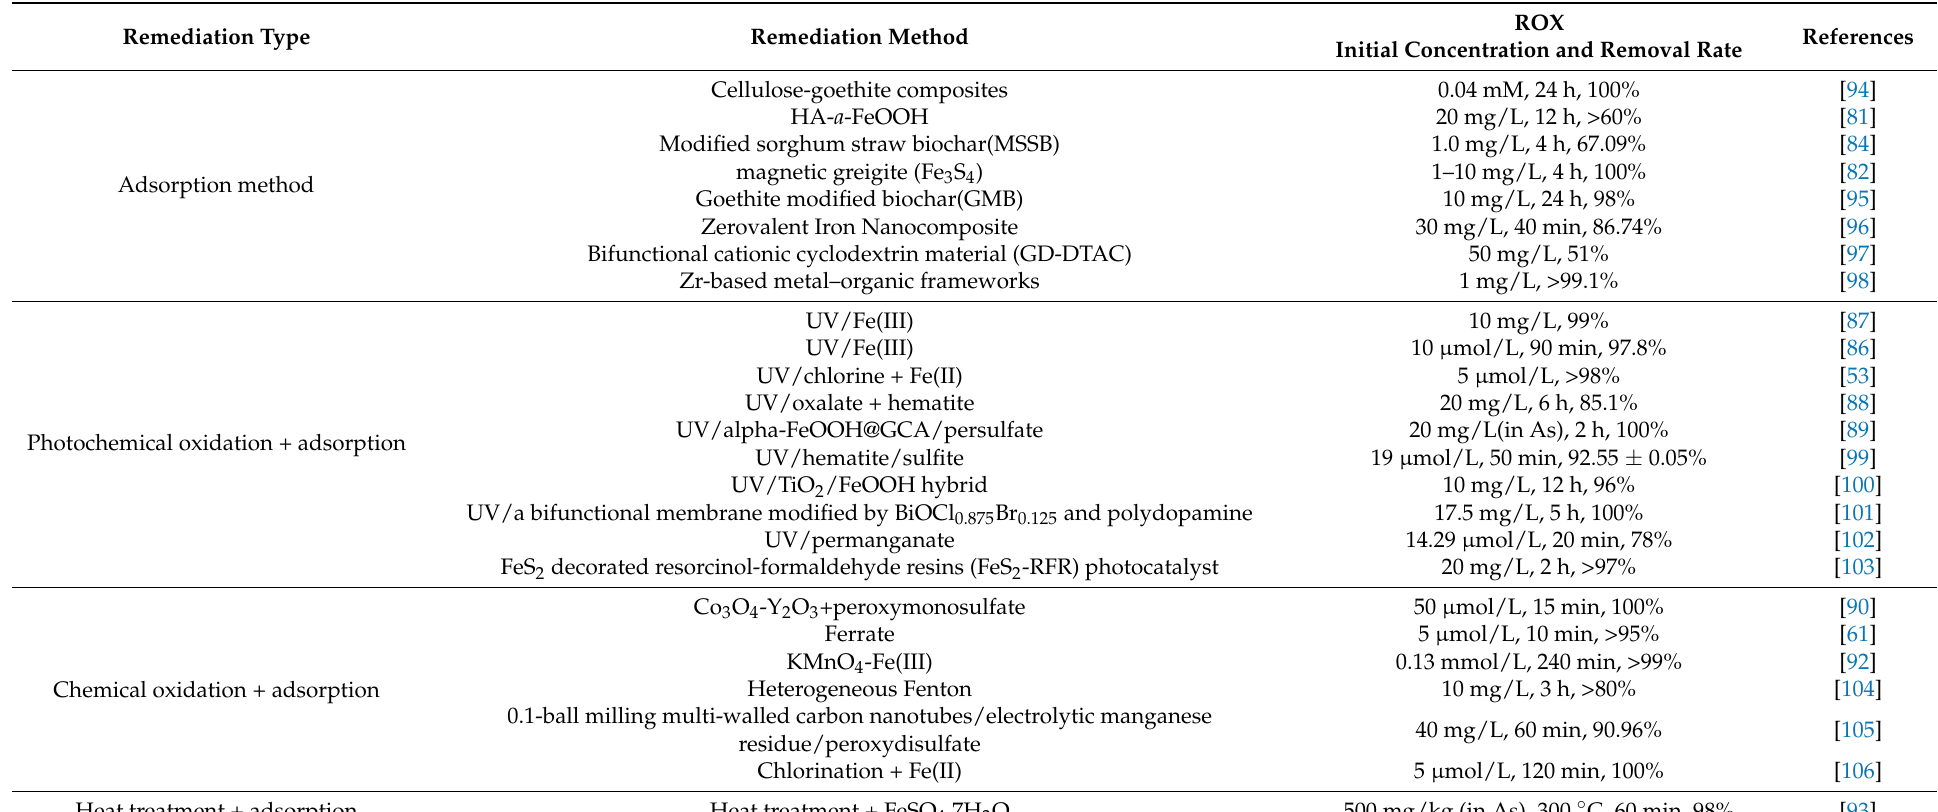
Table 2. ROX main pollution remediation